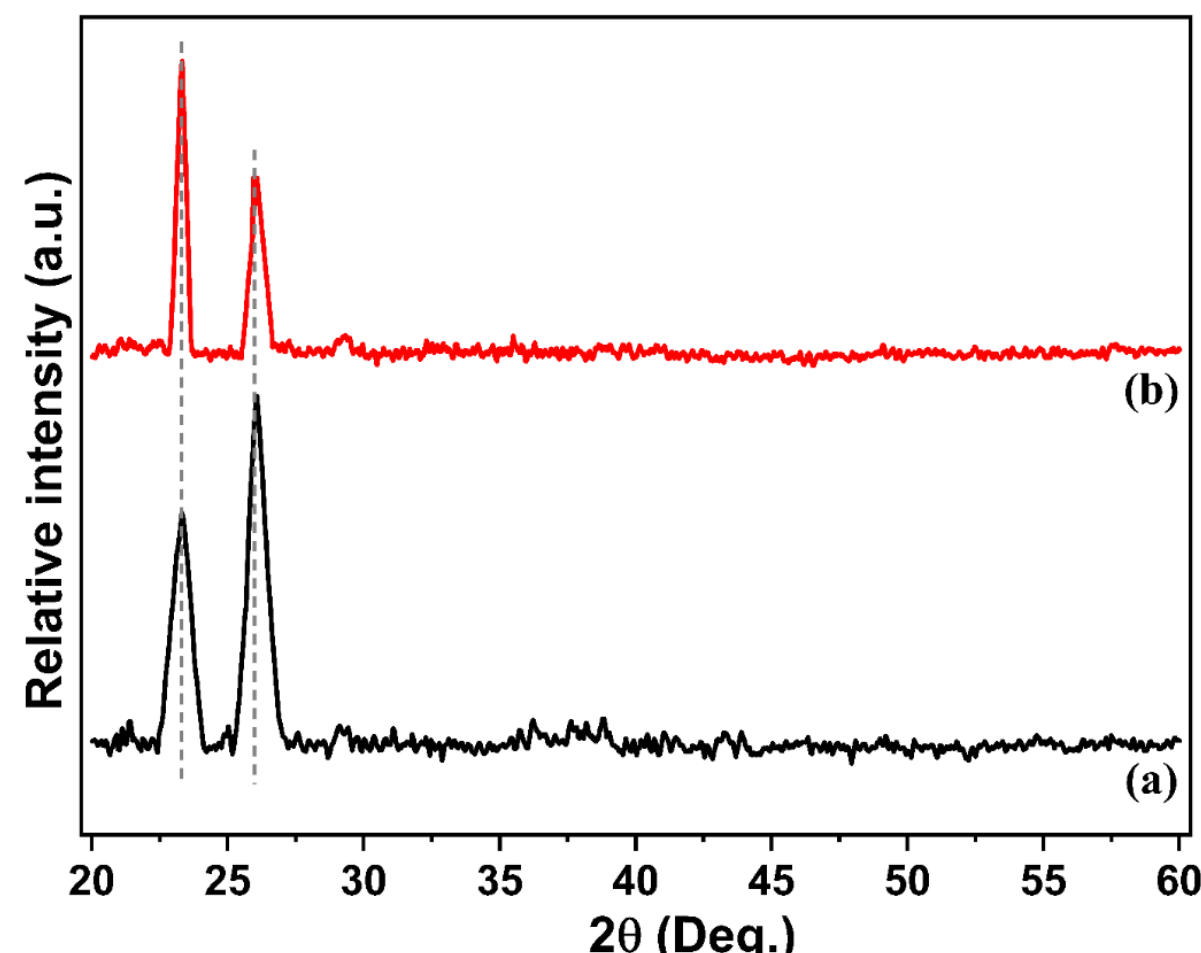
Figure 6. XRD pattern of film of CCMC ( a ) and OCMC ( b ).